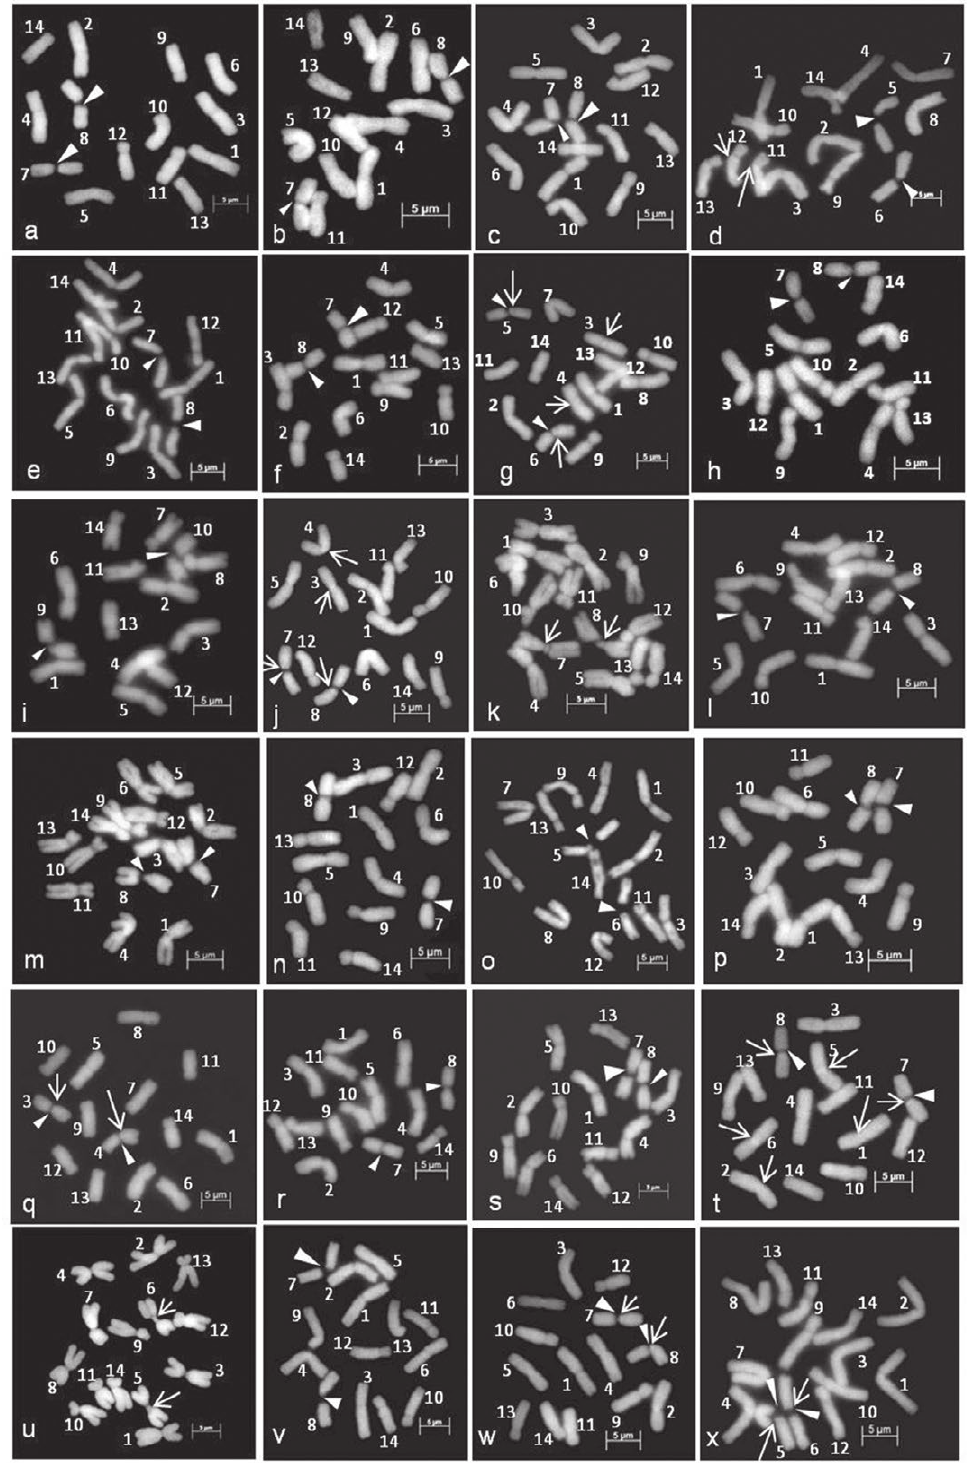
Figure 2. Somatic metaphase chromosomes of Lens culinaris cultivars stained with DAPI: (a) DPL-15, (b) DPL-62, (c) IPL-81, (d) IPL-406, (e) IPL-316, (f) JL-1, (g) HUL-57, (h) KLS-210, (i) EC-70394, (j) EC-70403, (k) EC-70404, (l) EC-78452, (m) EC-78455, (n) EC-78461, (o) EC-78475, (p) EC-78498, (q) EC-78542-A, (r) EC–223188, (s) EC – 255491, (t) EC–267526, (u) EC-267569-A, (v) EC–267590, (w) EC–267877, (x) Barasat Micro type. White arrows indicate DAPI + bands and arrowheads indicate DAPI - and DAPI 0 bands. Bars